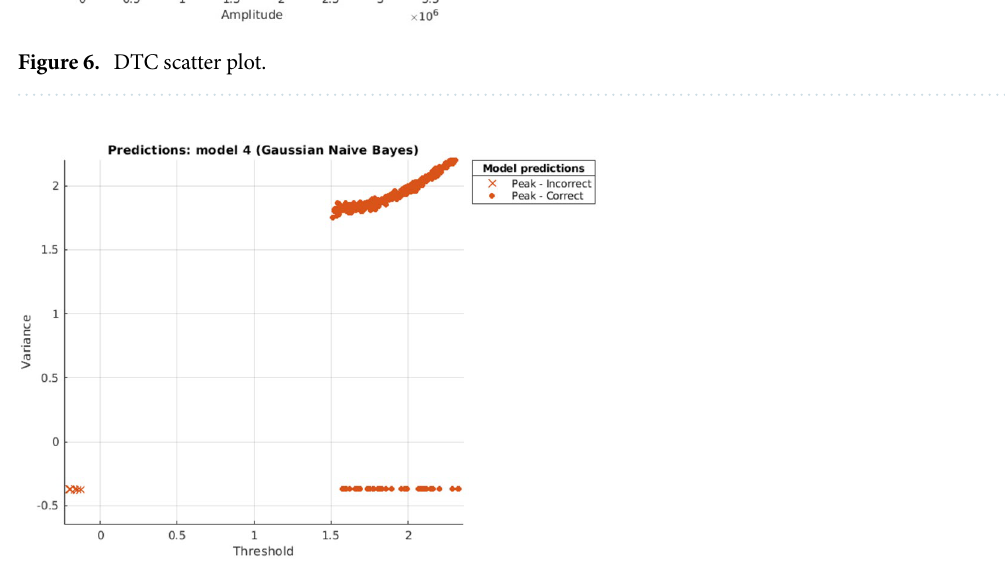
Figure 7. NB scatter